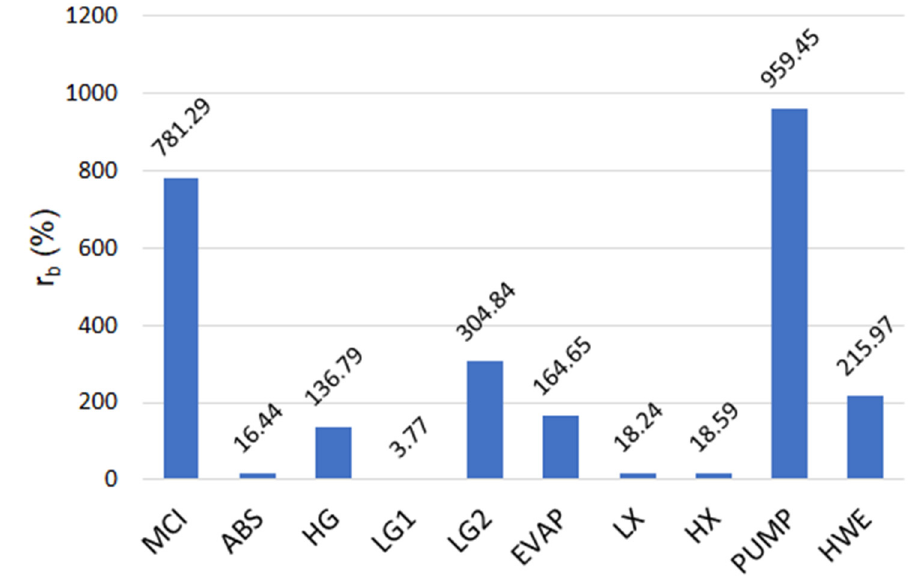
Figure 6. Relative difference of specific environmental impact per component.